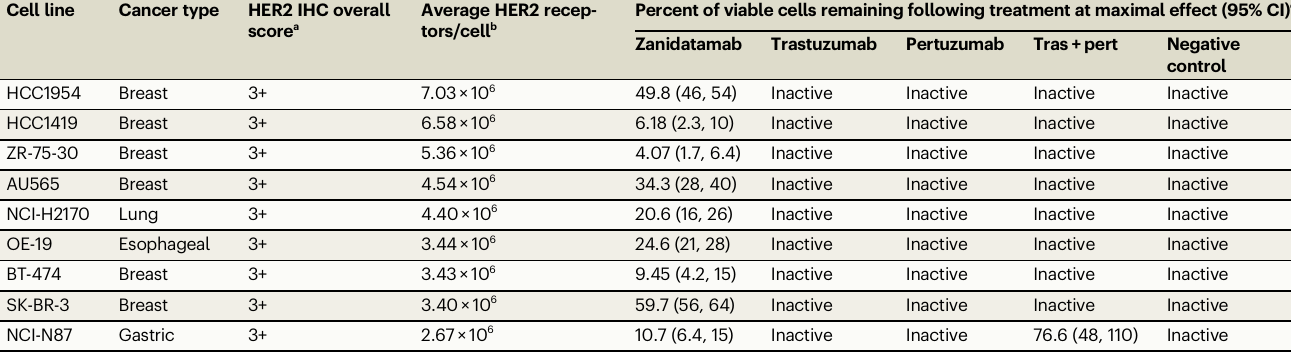
Table 1 | Percent complement-dependent cytotoxicity at maximal effect values of anti-HER2 Abs in HER2 expressing cancer cell lines Cell line Cancer